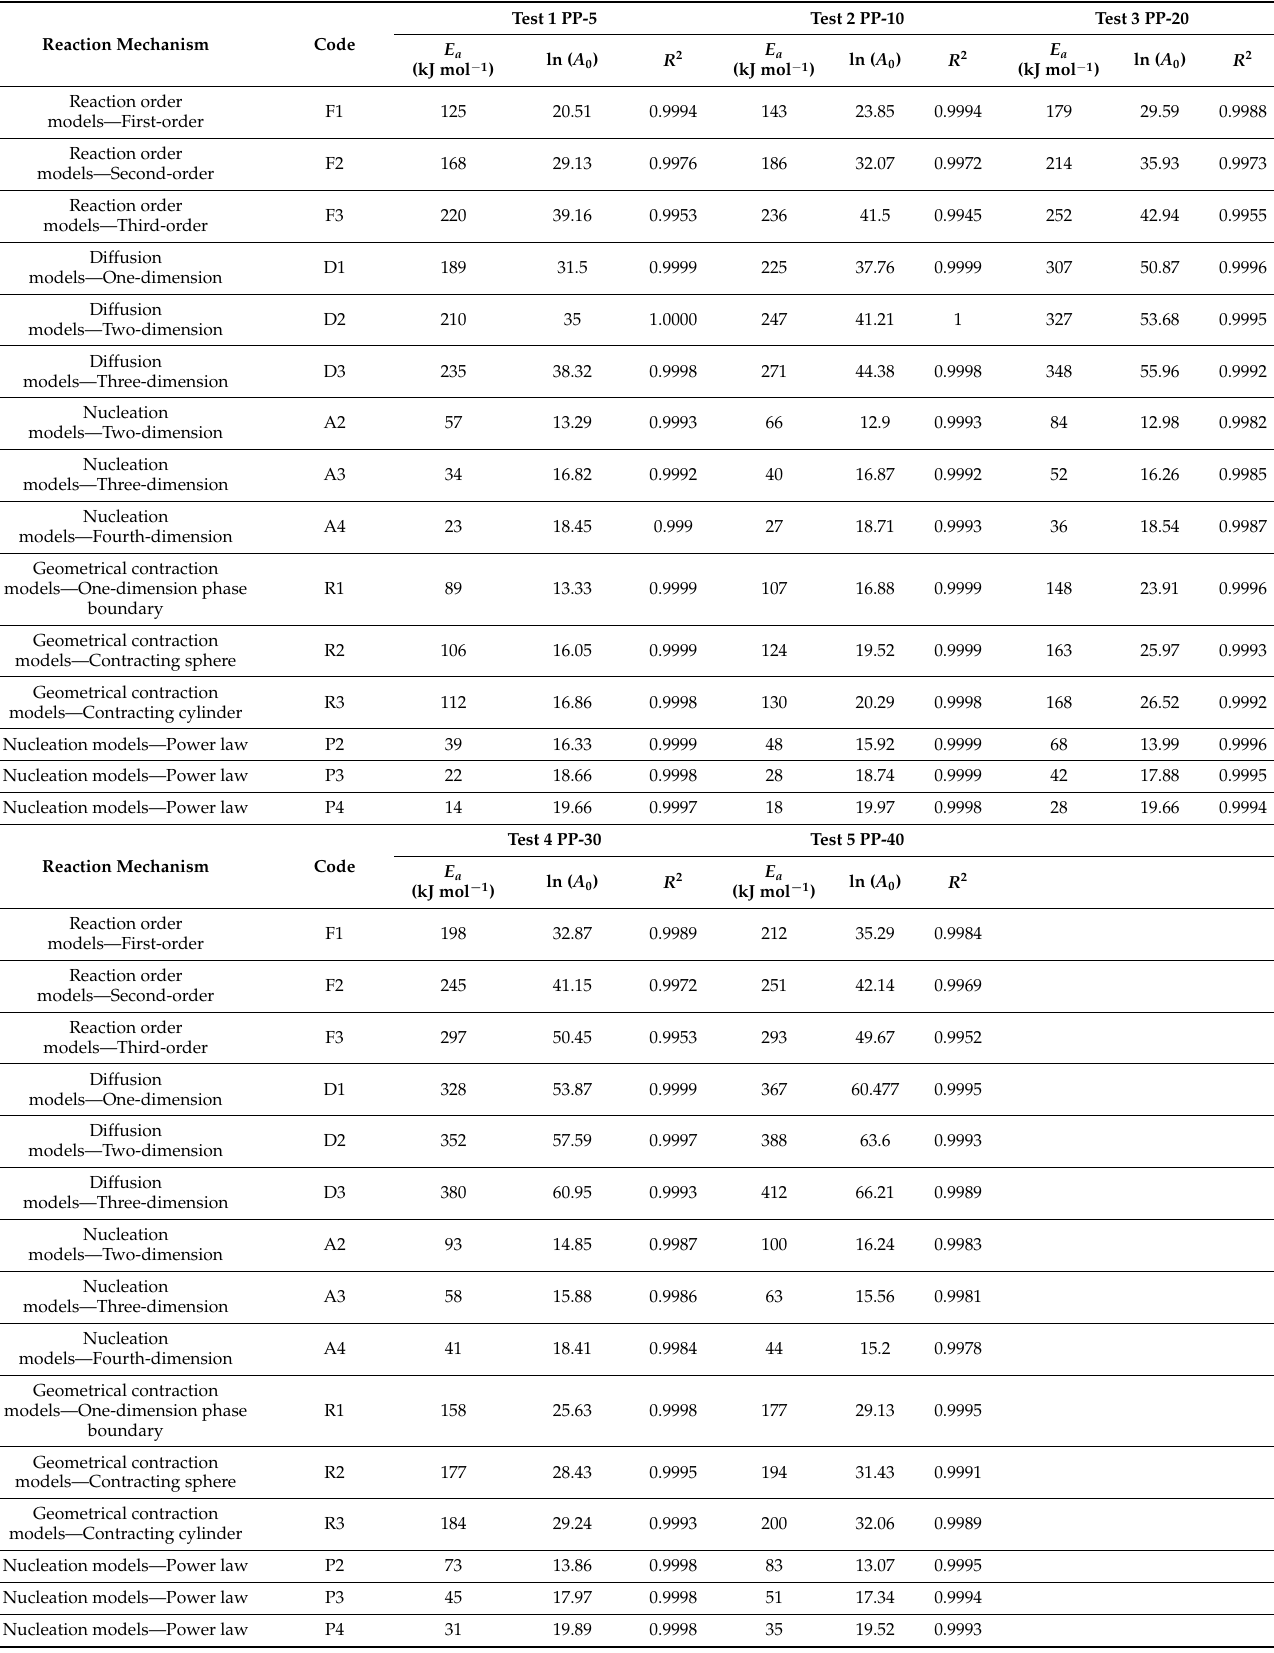
Table 8. Activation energies of the PP polymer by the CR